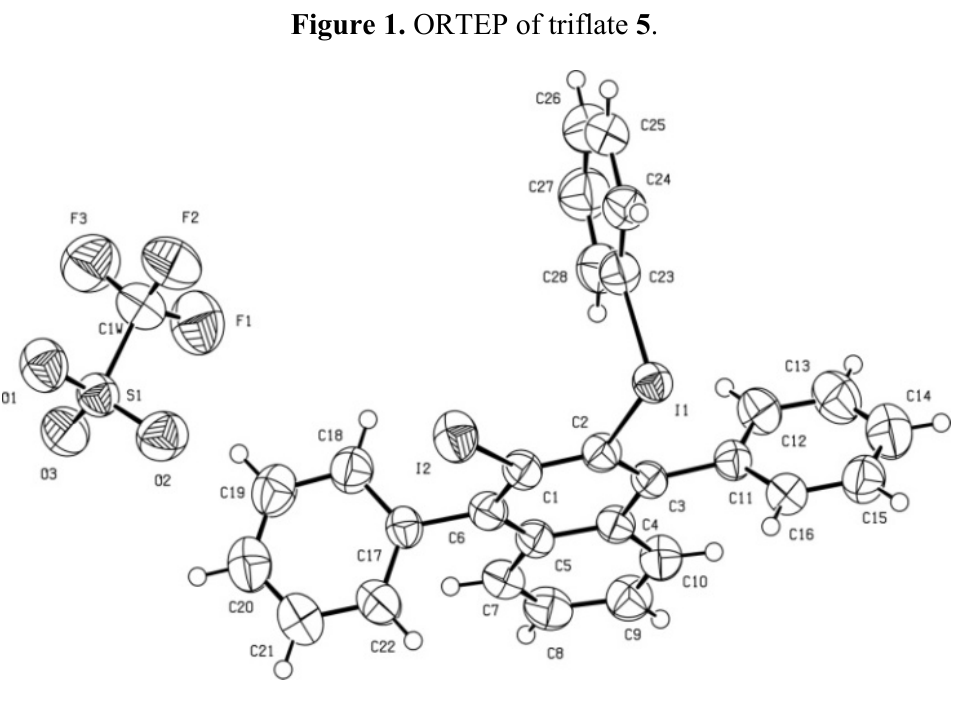
Figure 1. ORTEP of triflate 5